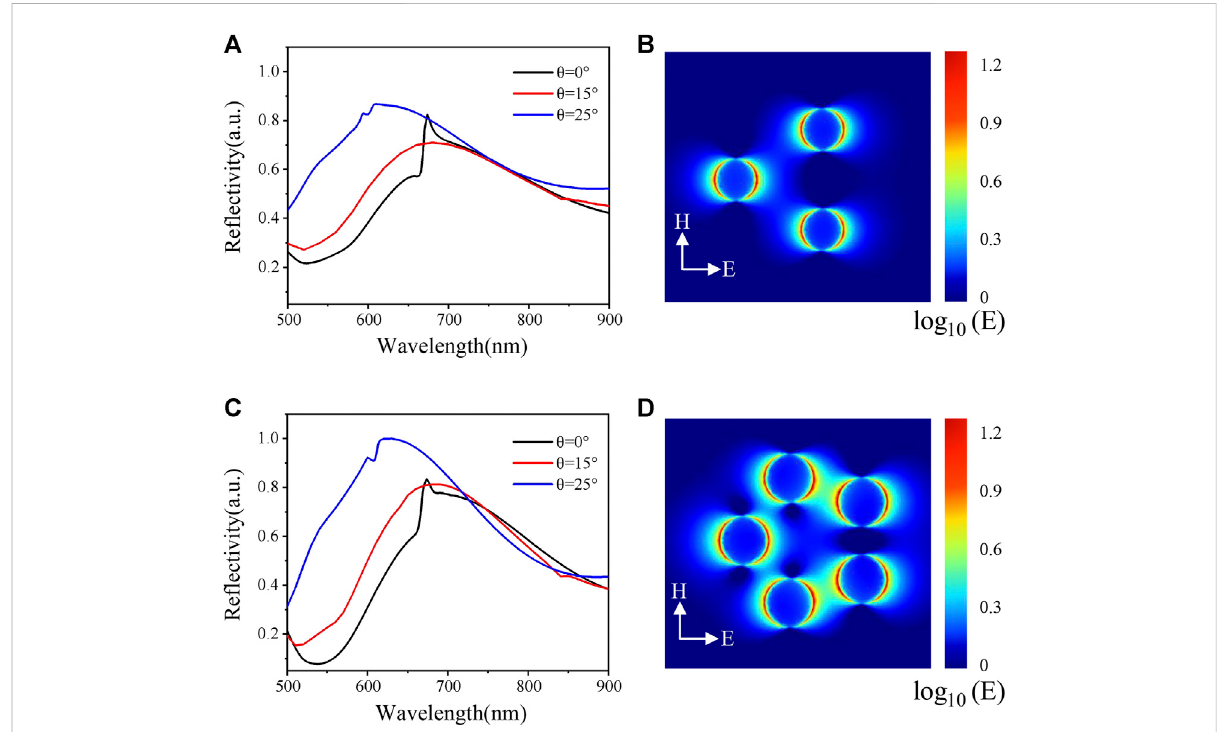
FIGURE 4 Numerically simulated re fl ection spectra of trimer or pentamer Au nano fi nger arrays with lattice constant of 670 nm. (A) Simulated re fl ection spectra of Au nano fi nger trimer arrays at the incidence angle of 0 ° , 15 ° , and 25 ° . (B) Electric fi eld distribution for the trimer Au nano fi nger arrays with normal incidence at peak of 670 nm. (C and D) Corresponding data for pentamer Au nano fi nger arrays.